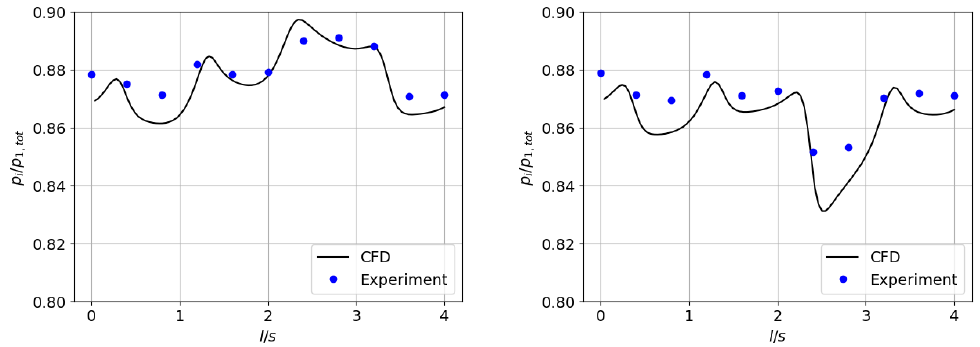
Figure 14. Pressure distribution along the inlet probe line ( left pane α = − 3°, right pane α =